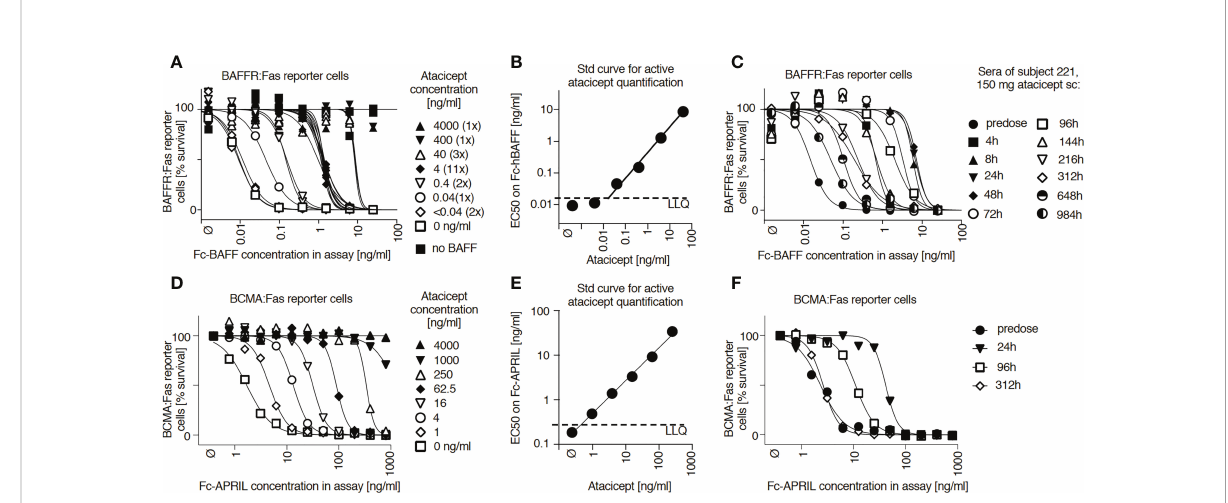
FIGURE 1 Measure of active atacicept in the serum samples from atacicept-injected subjects with a reporter cell-based assay. (A) Increasing concentrations of atacicept can block Fc-BAFF and prevent death of BAFFR : Fas reporter cells. (B) Linear relationship between the concentration of Fc-BAFF needed to kill half of BAFFR : Fas reporter cells and the concentration of atacicept. (C) Active atacicept concentration in subject ’ s serum is quanti fi ed be measuring the EC50 of Fc-BAFF on BAFFR : Fas reporter cells. (D – F) Same as panels (A – C) , but using BCMA : Fas reporter cells and Fc-APRIL to measure the ability of active atacicept to inhibit